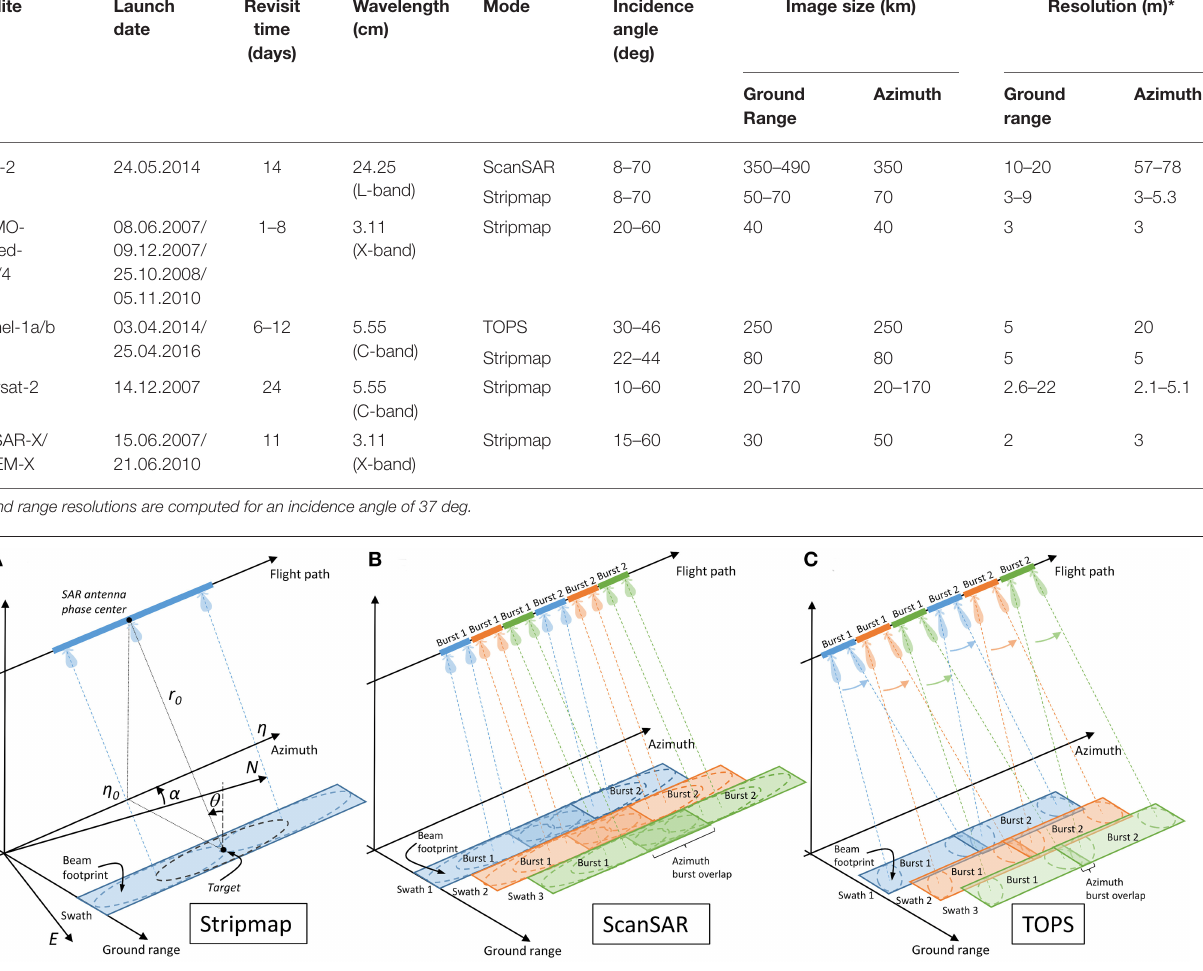
TABLE 1 | Properties of SAR sensors and modes currently used for coseismic deformation measurements. Satellite